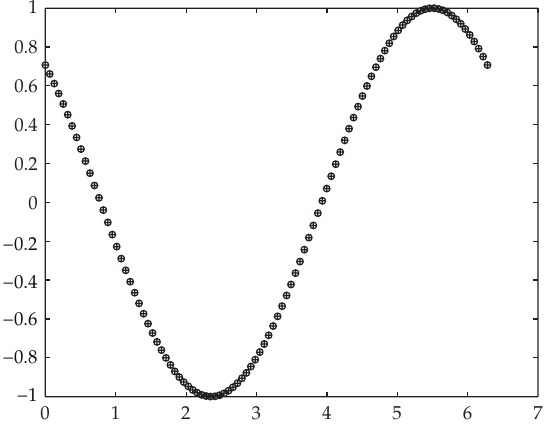
Figure 2: Index 1, T (cid:8) 2 π , the z -coordinate, “o”-original, “ (cid:9)